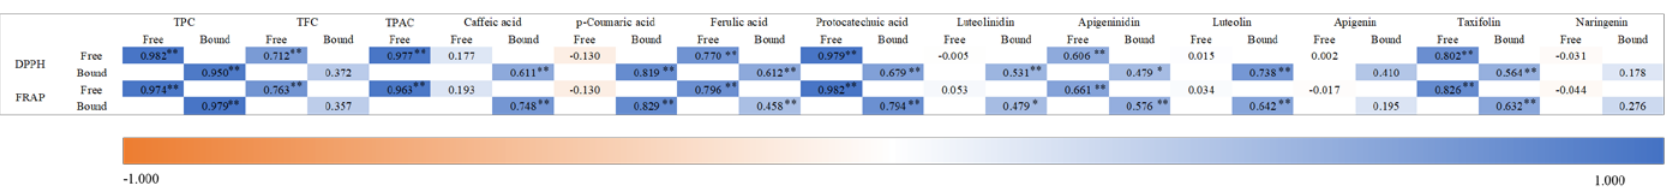
same fraction of the same assay are significantly different ( p ≤ 0.05).